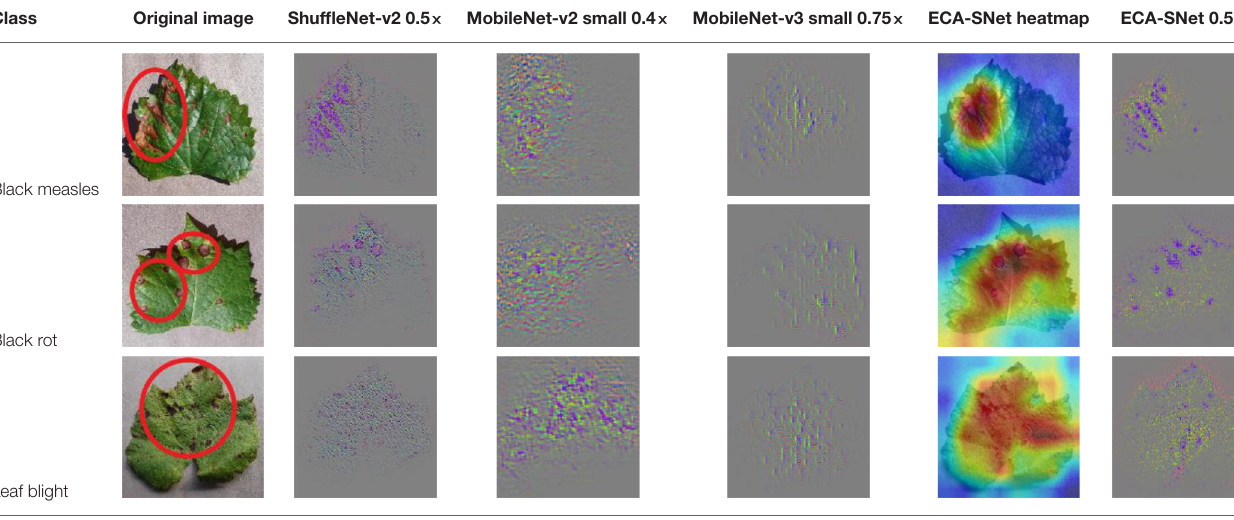
TABLE 6 | Fine-Grained feature visualization of grape leaf diseases.